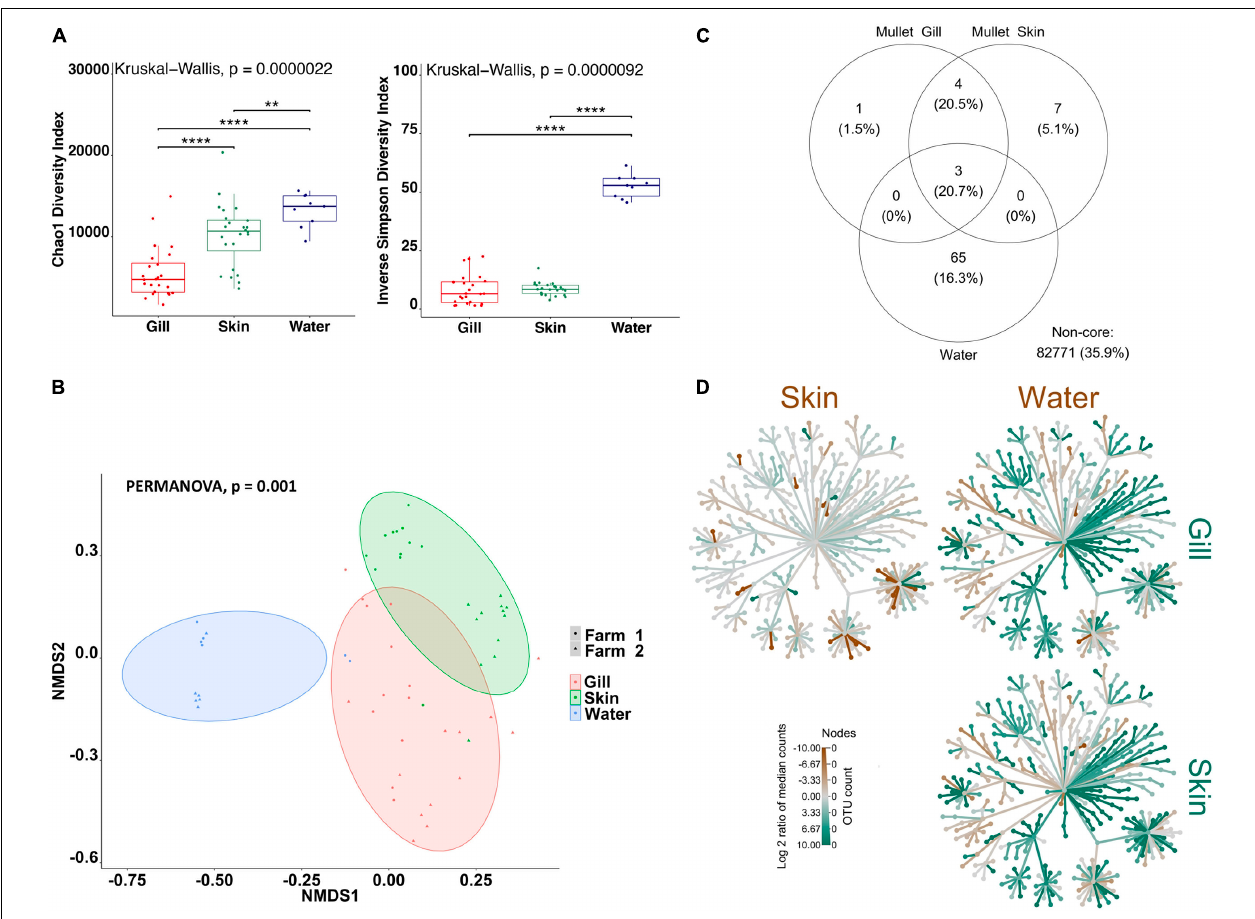
FIGURE 2 | Differential microbial communities in grey mullet external surfaces and pond water ( n =24 fish and n =12 water) across two farms. (A) Alpha-diversity metrics of mullet gill and skin microbial communities and pond water. Chao1 and Inverse Simpson were significantly different (Kruskal–Wallis, p < 0.00001) in water compared with gill and skin. Dots represent each individual sample, and ** p < 0.001 and **** p < 0.0001. (B) Non-metric multidimensional scaling (NMDS) plots based on Bray–Curtis similarity matrix of microbial communities [permutational multivariate ANOVA (PERMANOVA), p = 0.001]. The colors of the ellipses represent the three groups, and shapes represent the two farms. (C) Venn diagram of shared and unique operational taxonomic units (OTUs). The numbers of OTUs with at least 0.1% of relative abundance in 80% of the samples are displayed. Numbers in brackets represent the average relative abundance of the OTUs in that group. (D) Differential heat tree matrix showing taxa abundance variation between mullet gill, skin, and water represented in the dataset (RA > 0.01%). The trees illustrate the pairwise comparisons between the three groups. The color of each taxon represents the log-2 ratio of median proportions of reads observed in each group. Only significant differences, Wilcox rank-sum test followed by a Benjamini–Hochberg [false discovery rate (FDR)] correction are colored. Taxa colored green represent enrichment by row (left to right) and brown by column (top to